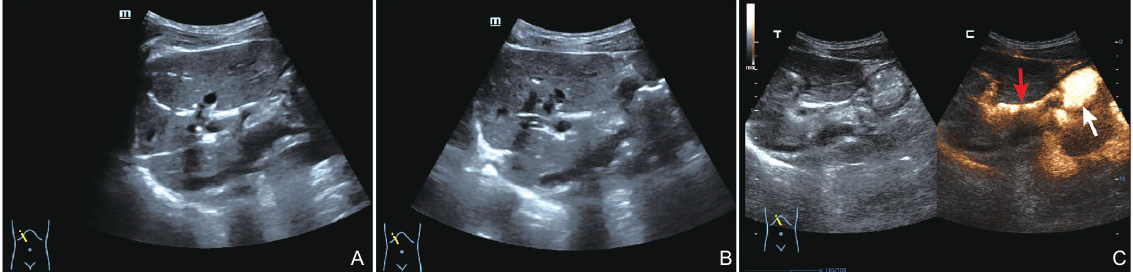
Figure 3 Abdominal ultrasonography. (A) Gray-scale ultrasonography showing pneumobilia and dilatation of the left intrahepatic bile duct; (B) Grayscal image before oral CEUS. The gastric organs and fistula could not be observed; (C) The left panel shows the fundamental mode, and the right panel shows the CEUS mode. The contrast agent was observed to fill in the stomach (white arrow). A hyperechoic fistula (red arrow) connected with the lesser curvature of the stomach and the left intrahepatic bile duct was